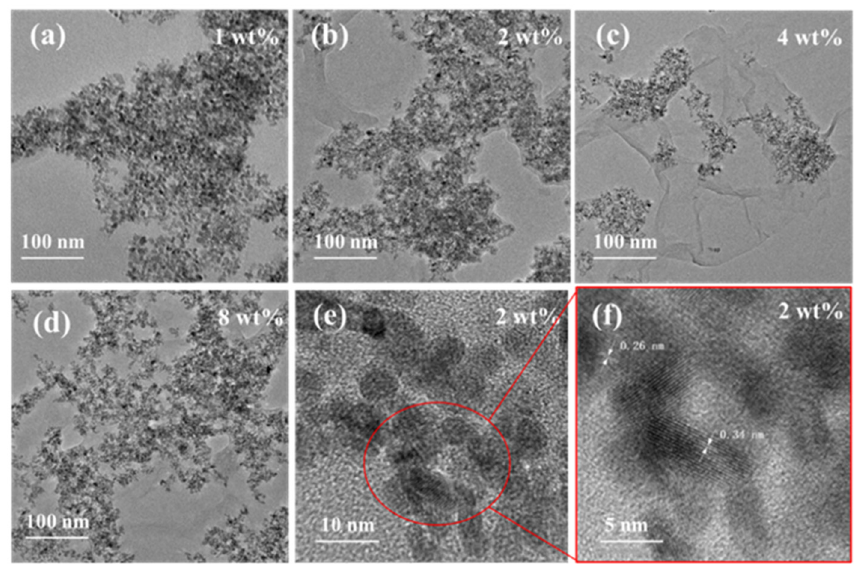
Figure 5. TEM images of SnO 2 /rGO nanocomposites samples. ( a ) 1 wt% SnO 2 /rGO, ( b ) 2 wt% SnO 2 /rGO, ( c ) 4 wt% SnO 2 /rGO, ( d ) 8 wt% SnO 2 /rGO, ( e , f ) HRTEM images of 2 wt% SnO 2 /rGO nanocomposites.